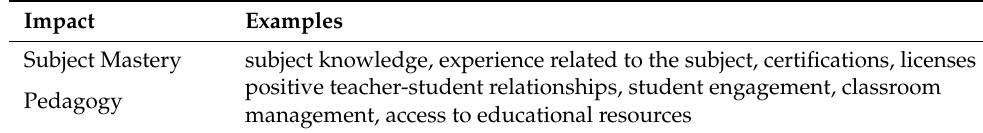
Table 2. Types of Educational impacts and